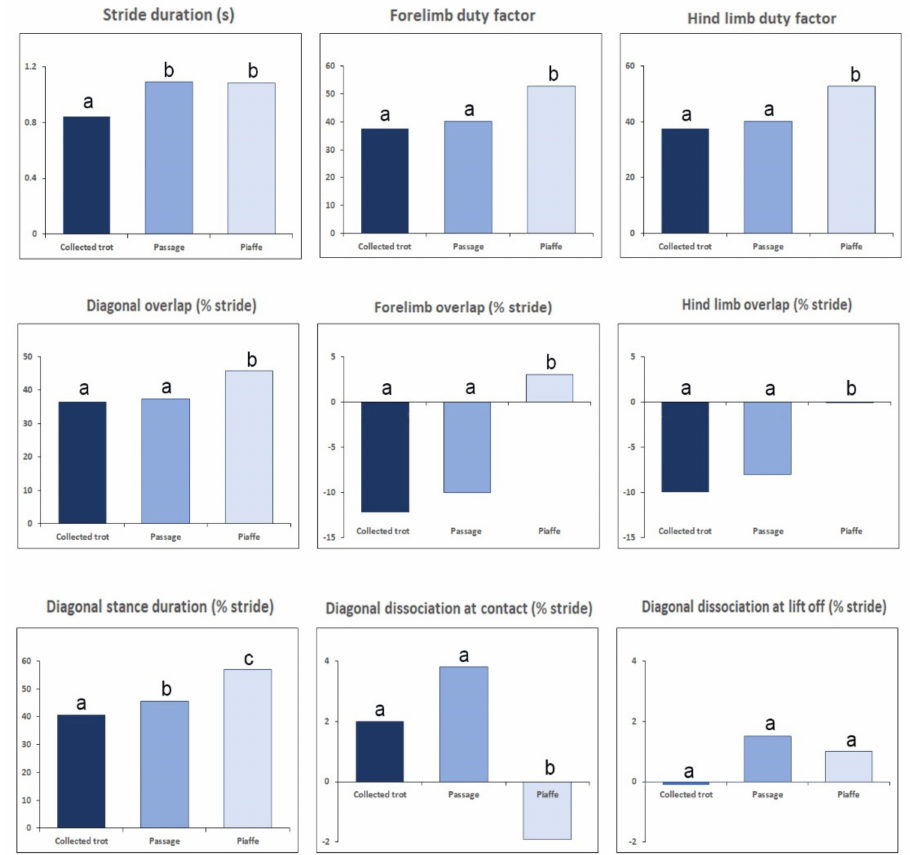
Figure 1. Mean values of temporal variables for collected trot, passage and pia ff e [25]. Within